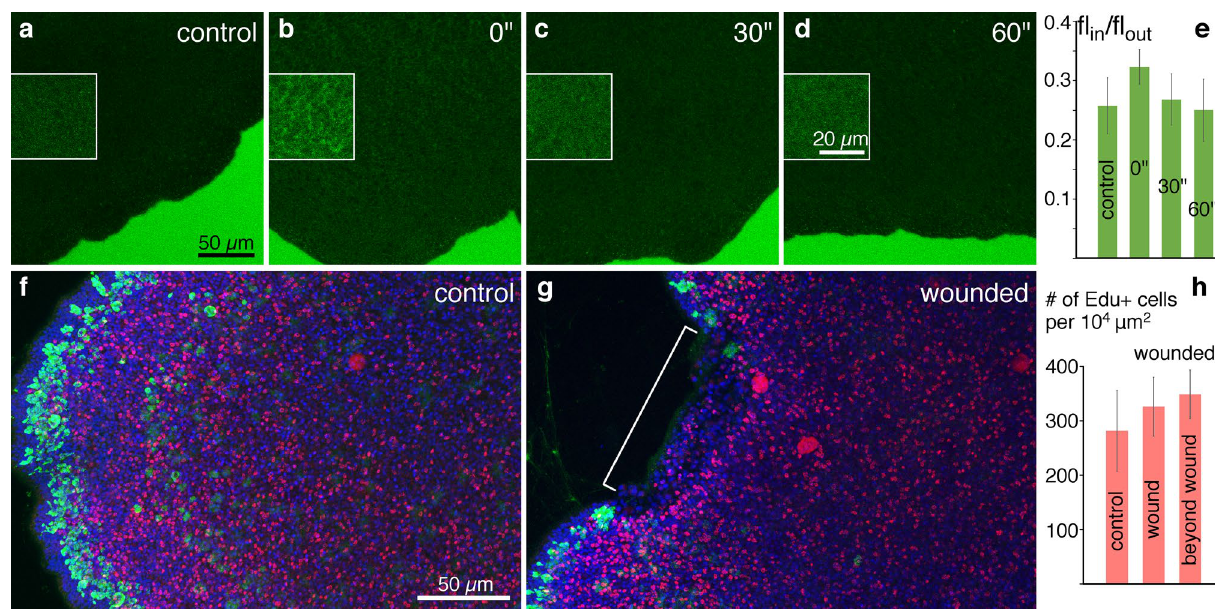
Figure 7. Estimation of the time required to seal the wound and proliferative activity during wound healing. ( a – d ) An area encompassing the edge of an animal bathed in 70 kDa FITC conjugated dextran (green); the amount of fluorescence inside the animal reflects the amount of dextran penetrated through the wound. Insets represent an enlarged area with enhanced brightness and contrast. ( a ) Control (intact) animal. ( b ) Dextran added before wounding. ( c ) Dextran added 30 s after wounding. ( d ) Dextran added 60 s after wounding. ( e ) Ratio of inside to outside dextran fluorescence in the animals in each experimental condition; no significant difference was found. Error bars are StDev. ( f, g ) Proliferative activity during 35 min (EdU labelling, red; WGA, green; DAPI, blue) in intact control animal ( f ) and after cutting ( g , wounded area marked with bracket) 35 min after surgery. ( h ) Mean number of EdU labeled nuclei in 10 4 µm 2 in lipophil area. No significant difference was found. Error bars are